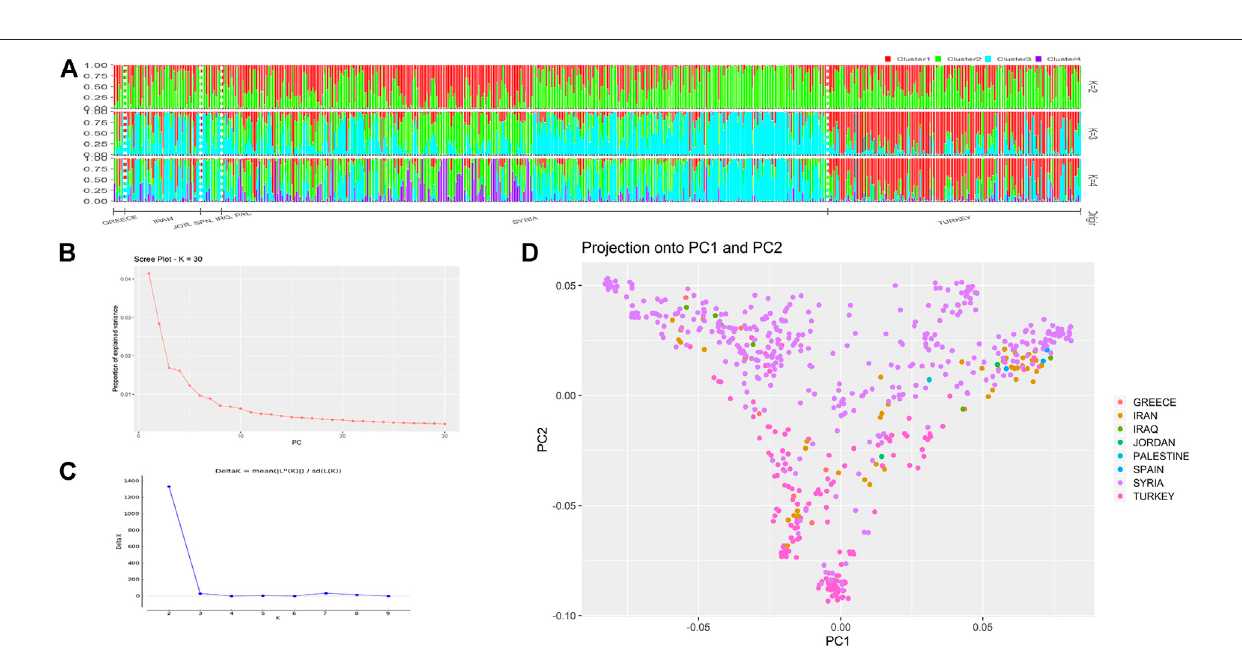
Frontiers in Genetics |